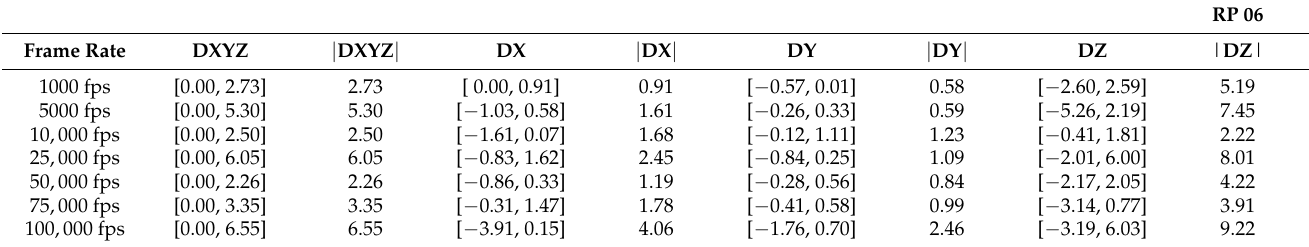
Table 4. Range variation of apparent displacements (total DXYZ , and for axis direction DX , DY , and DZ ) for RP 06, in [ µ m].